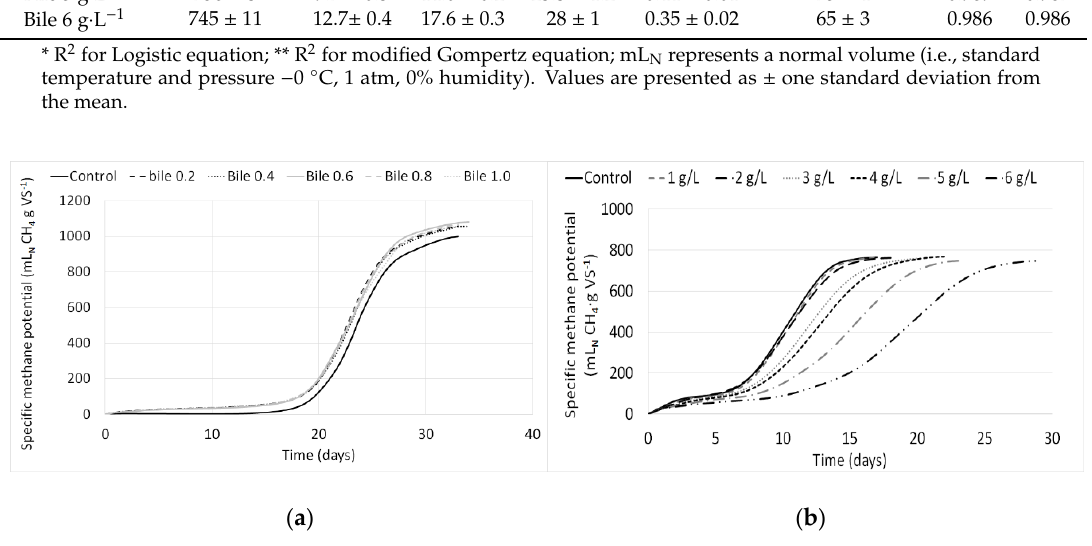
Figure 6. Specific methane potential from DAF sludge treated with bile in doses ranging from: ( a ) 0.2–1 g bile · L − 1 and; ( b ) 1–6 g bile · L − 1 [43]. Equation (1): Growth curve logistic equation.